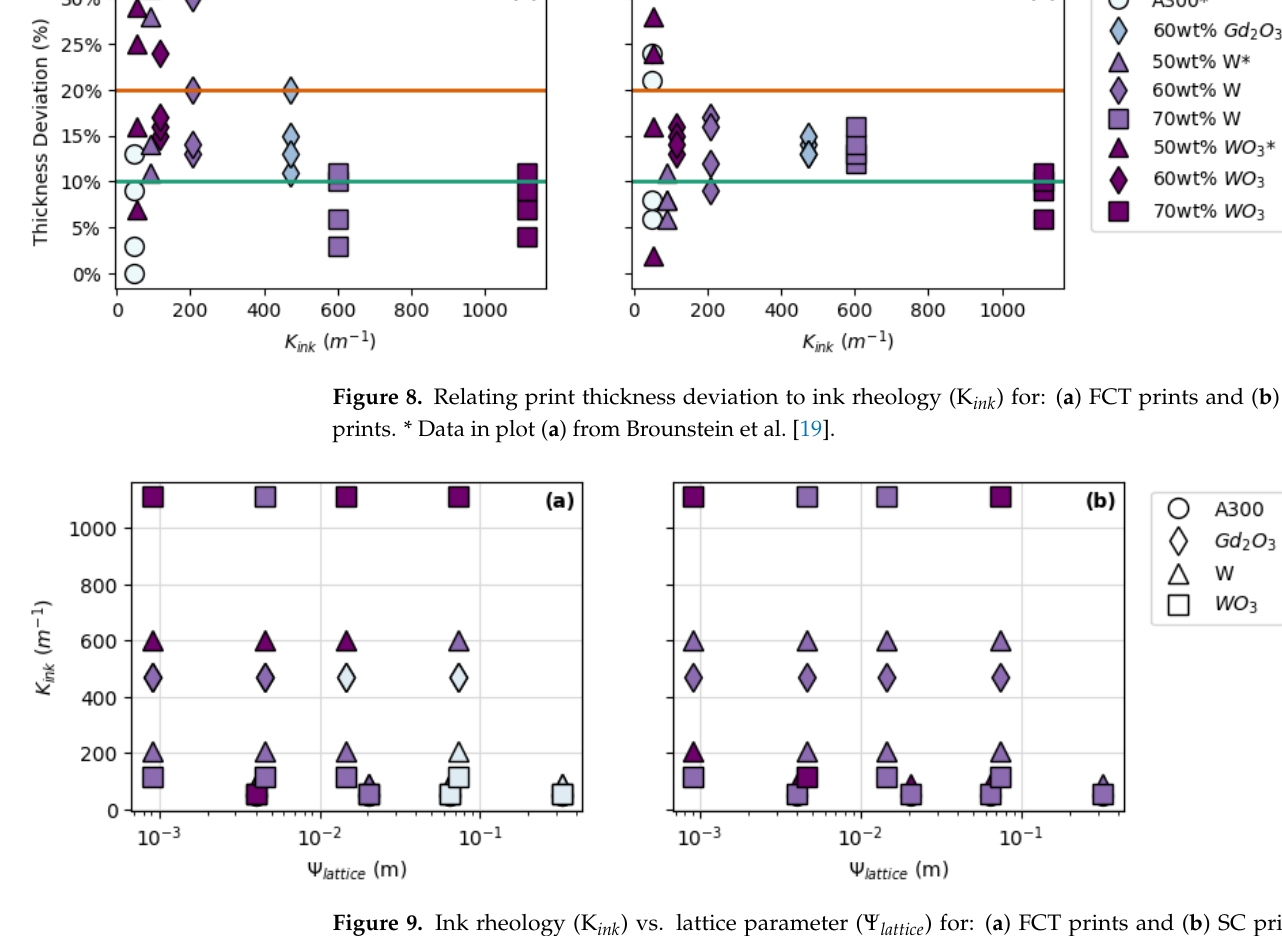
The darkest symbols represent pads with <10% thickness deviation; the second-darkest symbols repre-